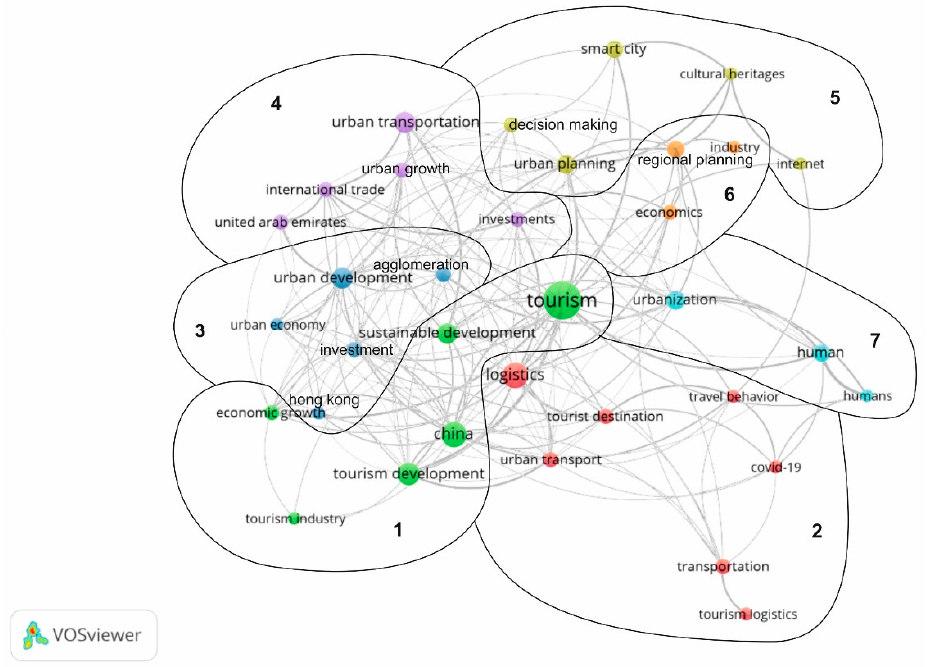
Figure 3. Map of links between the analysed keywords (1–7-cluster number). Source: Own elabora- tion using the VOSviewer software.